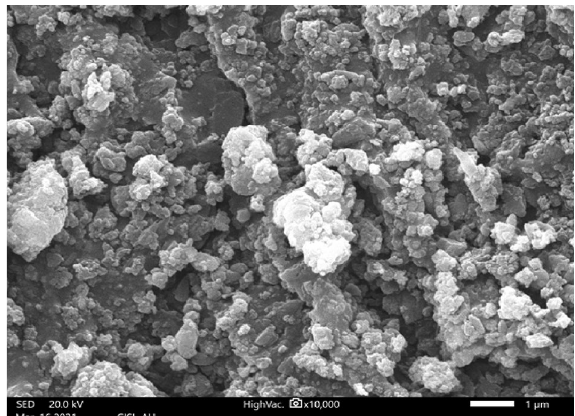
Figure 8. SEM of drug loaded nanoconjugate.